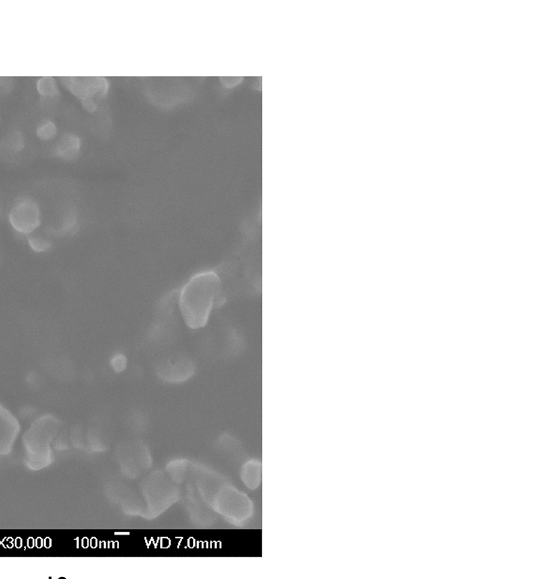
Fig 2. Cytotoxicity tests of compounds by MTT assay. Cells were treated with various compounds for 4h, and grown for another 20h. (A)IC50 of HeLa and HepG2 cells (B)HEK-293T cells Data represent the mean ± standard deviation (n = 6).